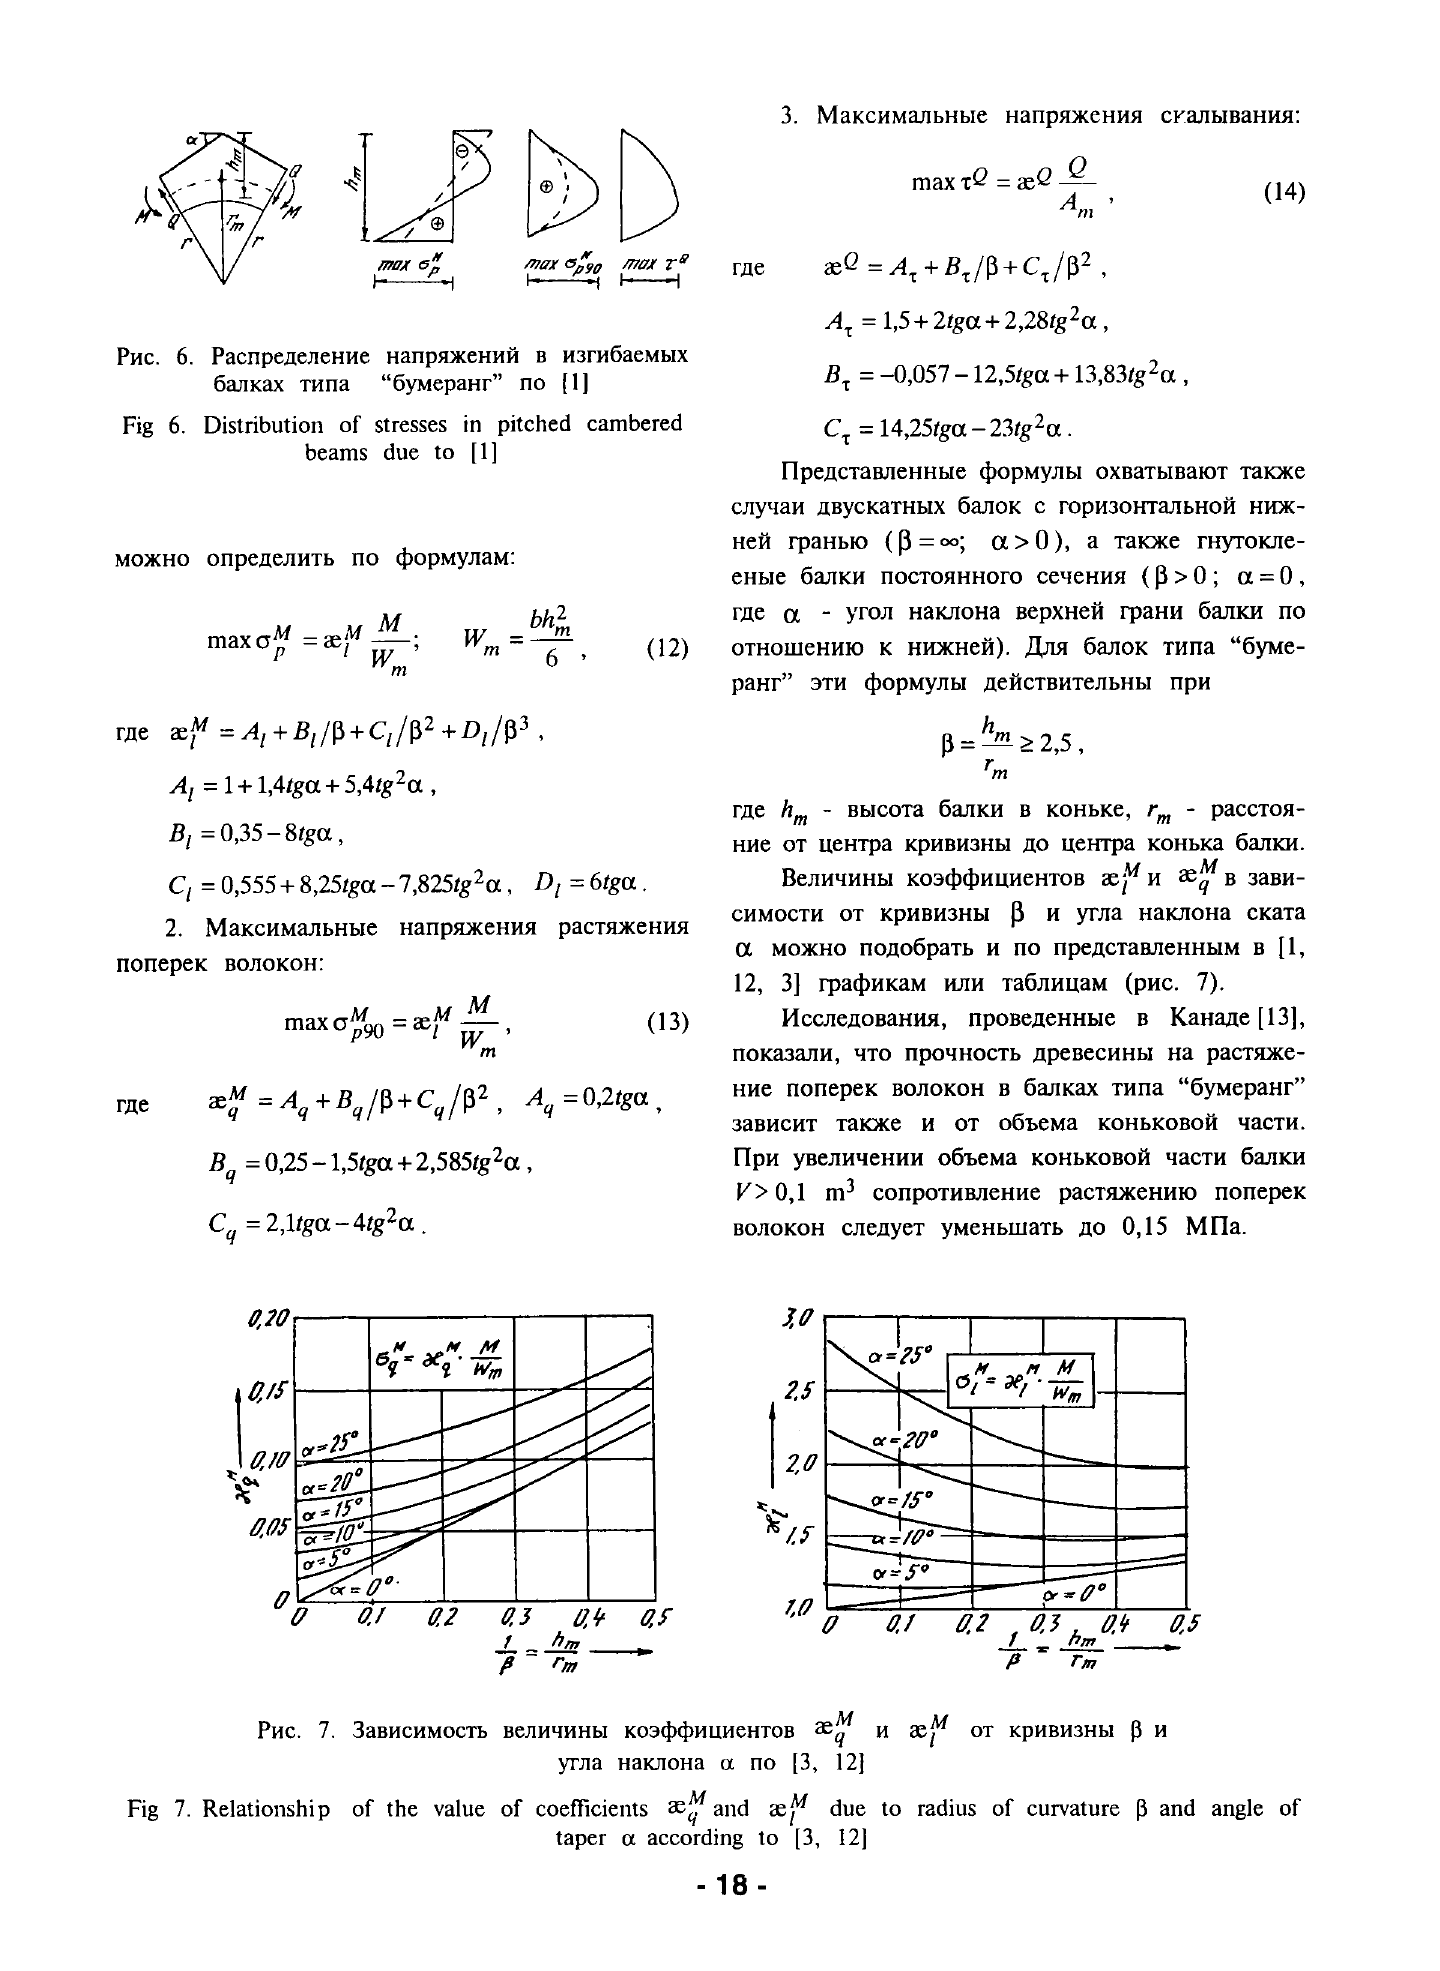
Fig 7. Relationship of the value of coefficients